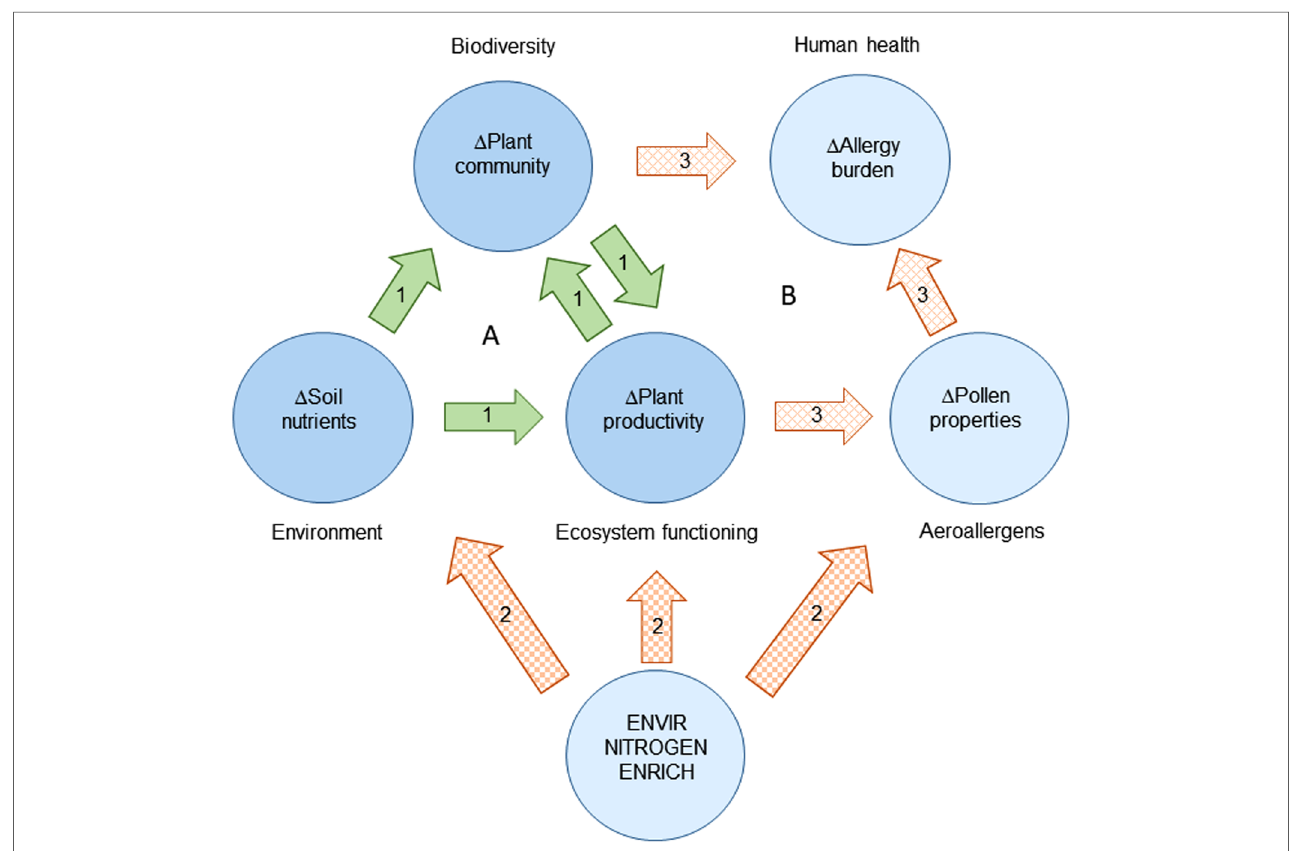
FIGURE 1 Environmental nitrogen pollution and the burden of allergic disease in the light of environment, biodiversity, and ecosystem functioning. ( A ) Under the present “ biodiversity-ecosystem functioning ” paradigm, biodiversity and environmental variation drive ecosystem functioning, such as plant productivity (arrow set 1). ( B ) Environmental nitrogen pollution may drive changes in the burden of pollen allergies through a combination of direct changes (arrow set 2) and indirect changes (arrow set 3) in the abiotic environment, plant species composition, plant productivity, airborne pollen species composition and abundance, and, importantly, allergen